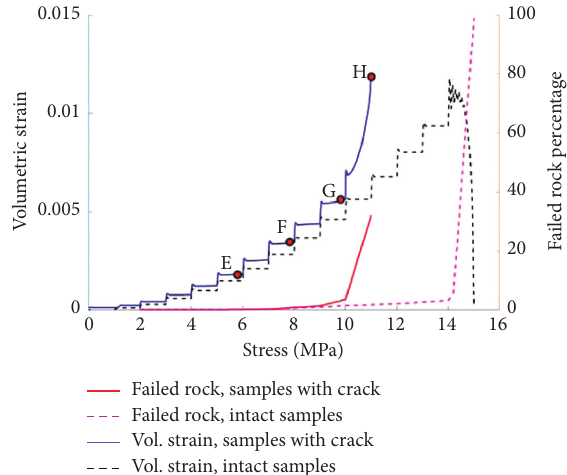
Figure 10: TWC test loading curve and the failed rock percentage during the loading process for a rock sample containing an initial crack (similar results for the intact rock sample are plotted for